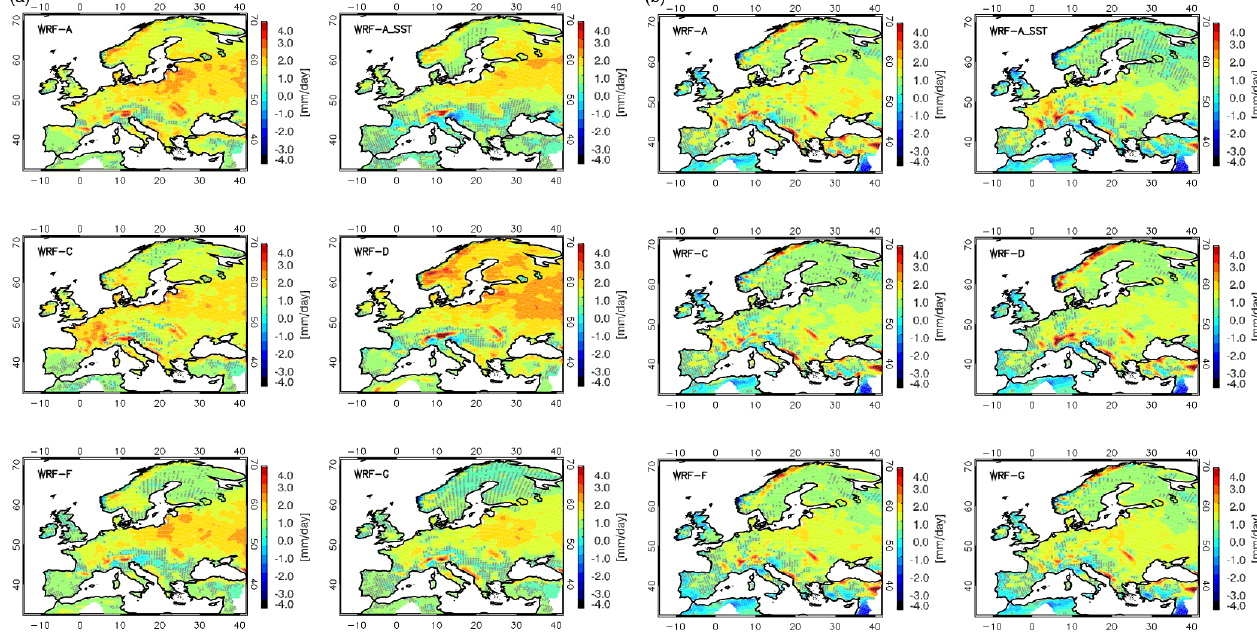
Figure 3. (a) Mean summer and (b) mean winter 1990–2008 precipitation bias (model-E-OBS9) (expressed in mmday − 1 ). Stippling indi- cates areas where the biases are not statistically